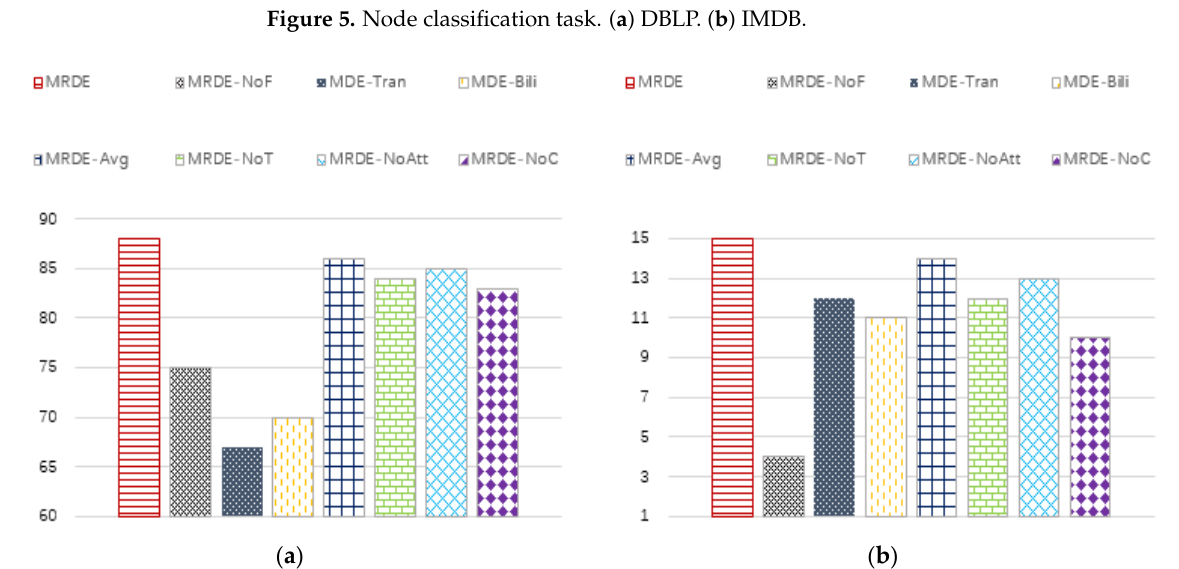
Figure 5. Node classification task. ( a ) DBLP. ( b ) IMDB.